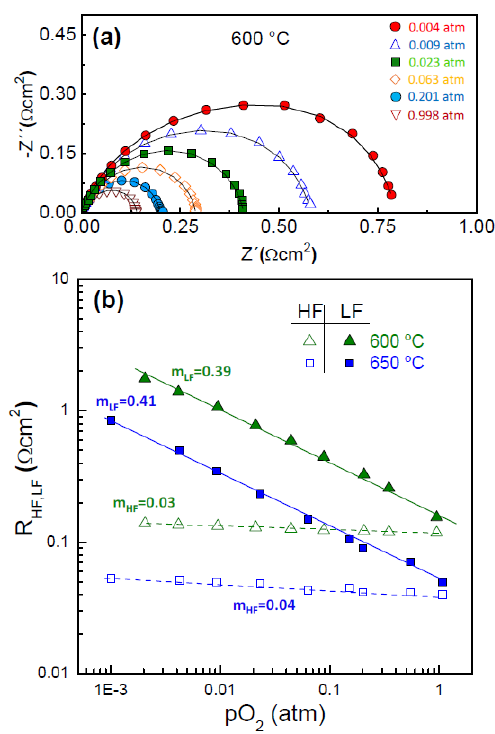
Figure 4. ( a ) Impedance spectra of SP electrode at 600 ° C at different pO 2 values. ( b ) Polarization resistance of the different electrode contributions as a function of pO 2 .